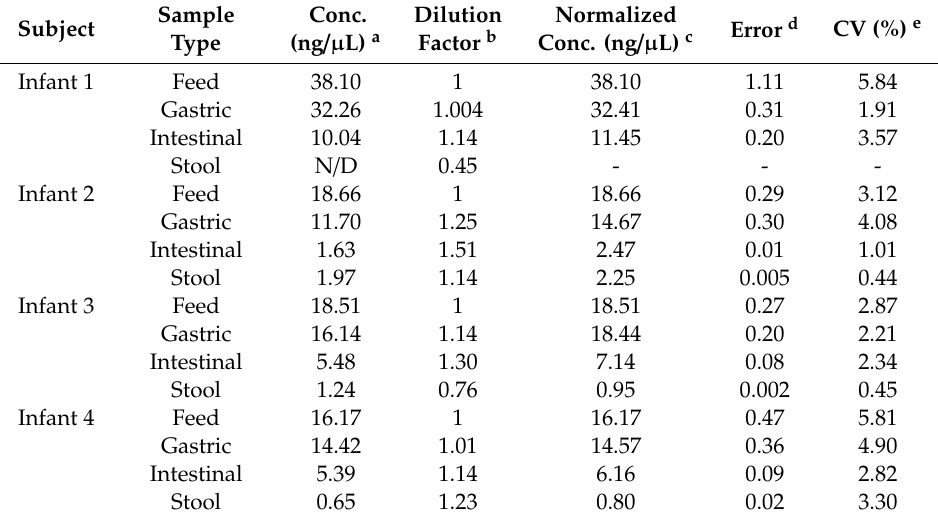
Table 3. Concentrations of palivizumab found from feed (human milk), gastric, intestinal and stool samples by parallel-reaction monitoring (PRM)-based